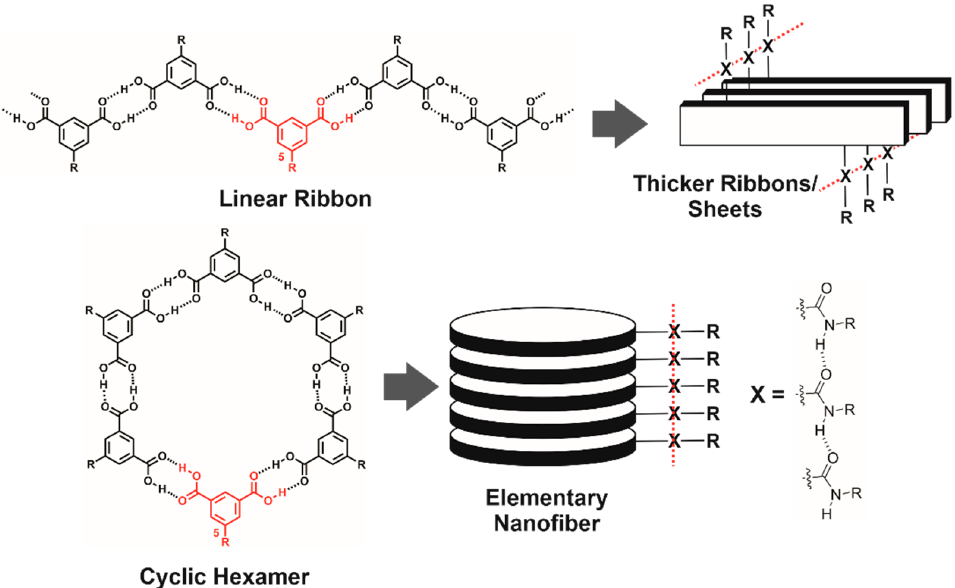
Figure 1. Hierarchical self-assembly of ISA derivatives.